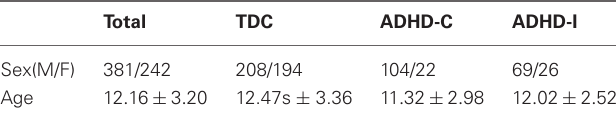
Table 2 | The demographic information of selected